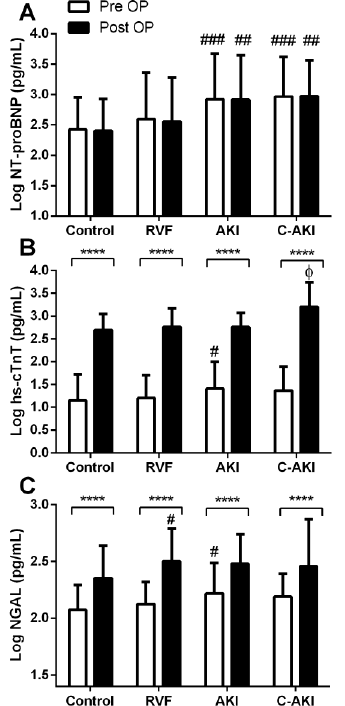
Figure 1. Baseline and postoperative biomarker levels in patients who developed congestive acute kidney injury (c-AKI) vs. controls. **** Within group differences (baseline vs. postoperative) p < 0.0001. # Significantly different than control p < 0.05, ## p < 0.01, ### p < 0.001. Φ Significantly different than control, right ventricular failure (RVF), and AKI, p < 0.05.